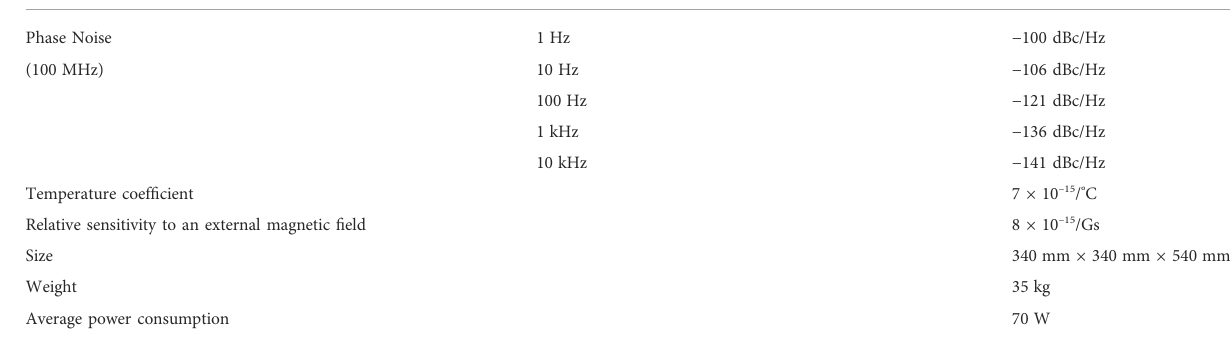
TABLE 2 Parameters of the SAHM.